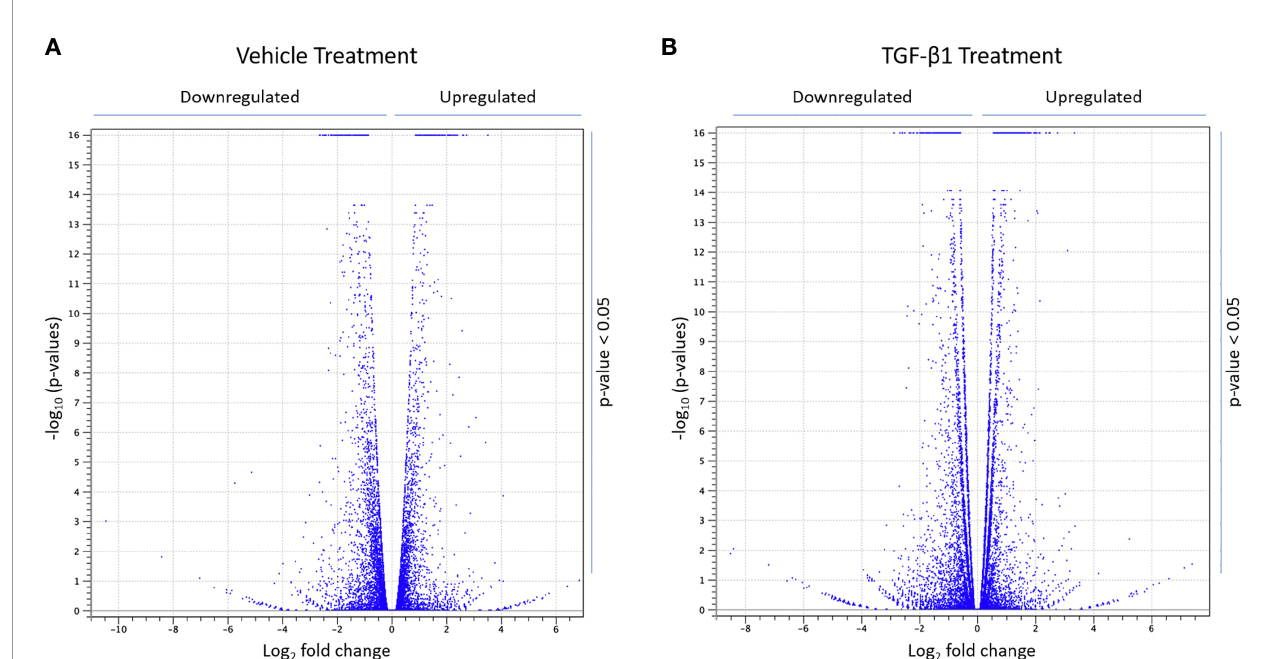
FIGURE 2 | RNAseq data demonstrating the effects of LMTK2 KD on the mRNA landscape in the presence and absence of TGF- b 1 stimulation. Volcano plot showing differential gene expression after LMTK2 KD in vehicle-treated (A) or TGF- b 1-treated (B) CFBE41o- cells. CFBE41o- cells transfected with siLMTK2 or siCTRL were treated with vehicle control or TGF- b 1 for 24h. Total RNA was isolated using Quick-RNA ™ MiniPrep kit (Zymo Research) and quanti fi ed on Illumina NextSeq 500 ’ s (Illumina). Data are expressed as Log2 fold change (FC) in cells transfected with siLMTK2, compared to siCTRL. N=3 for each